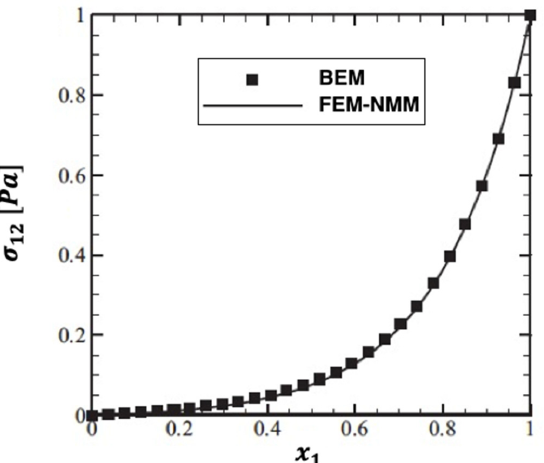
Figure 20. Variation of the thermal stress wave 𝜎 (cid:2869)(cid:2869) along 𝑥 (cid:2869) – axis in the special case of the func- tionally graded anisotropic fiber-reinforced plates for BEM and FEM-NMM.